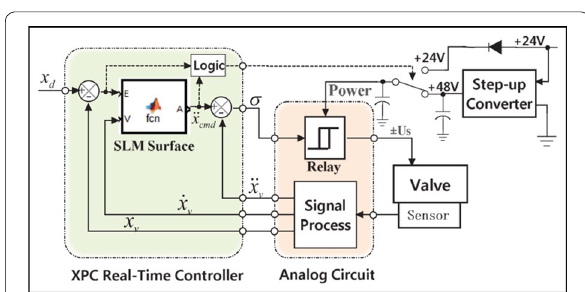
Figure 8 Schematic of the SLM controller with the switch of power